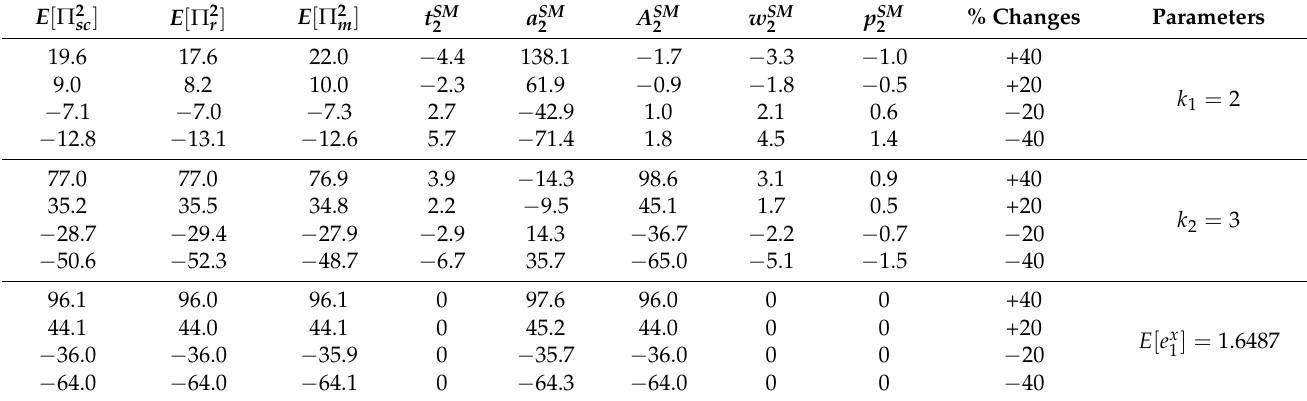
Table 12. The results of the sensitivity analysis with a SG-ML for the second model.